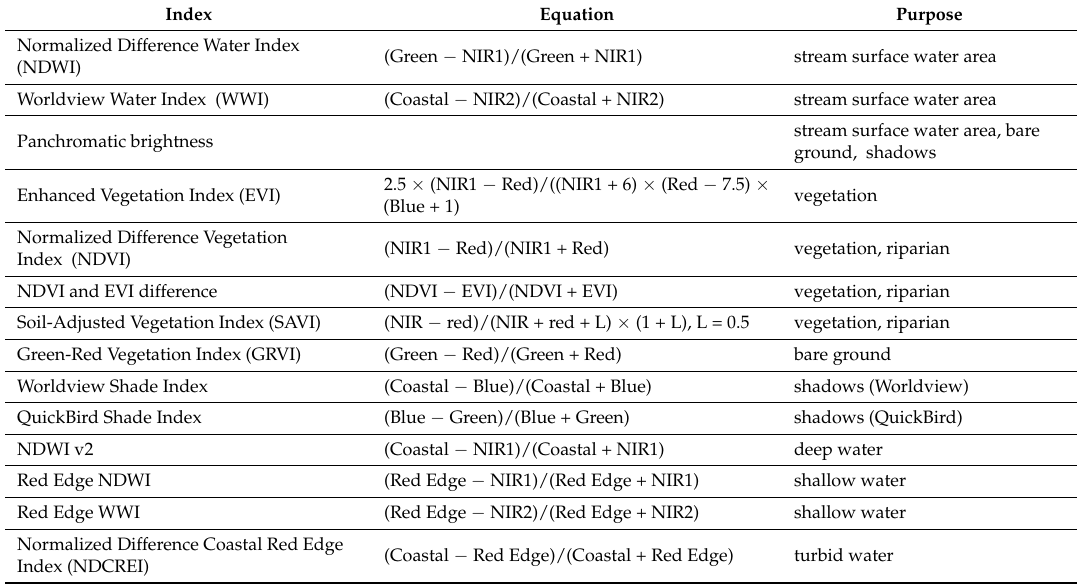
Table 2. Spectral indices used in object-based and pixel-based classification of surface water, as well as the characterization of riparian greenness. NIR: near